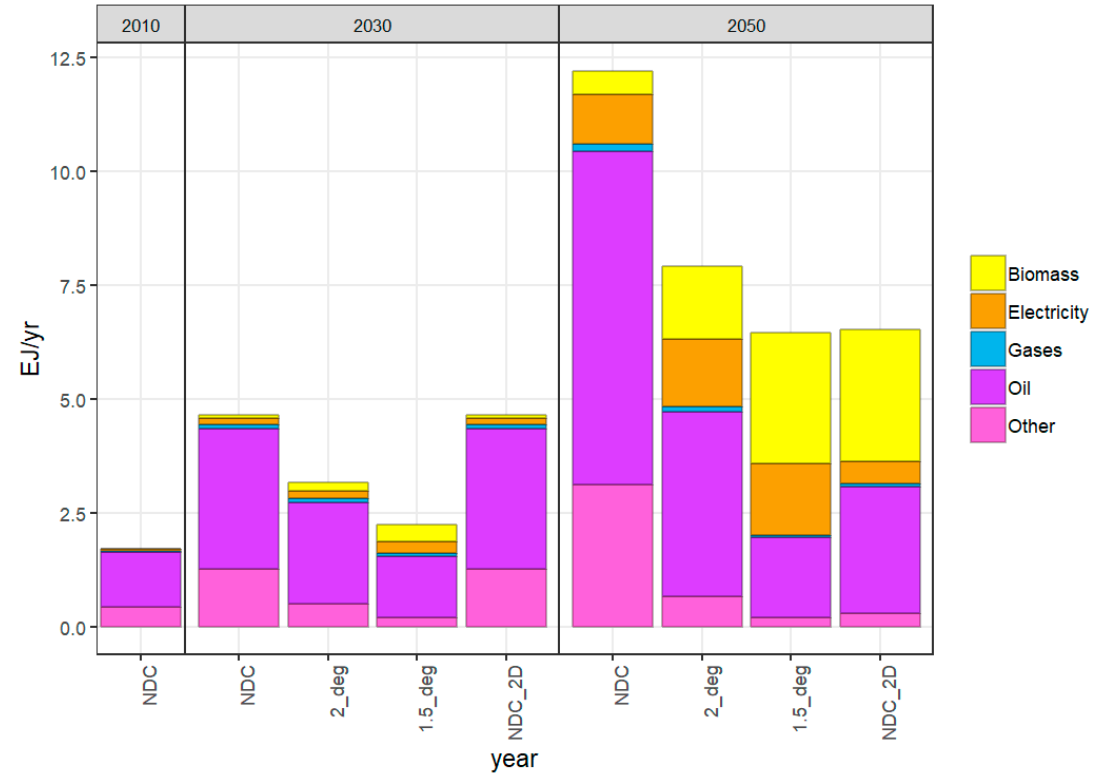
Figure 8. Transport mix in different scenario.